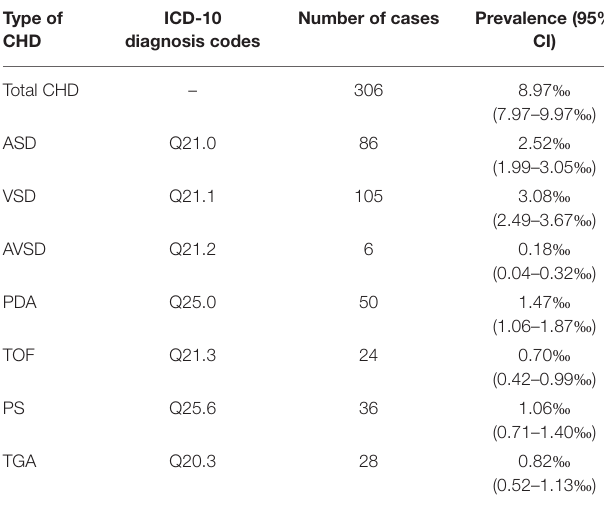
TABLE 1 | Prevalence of CHD in